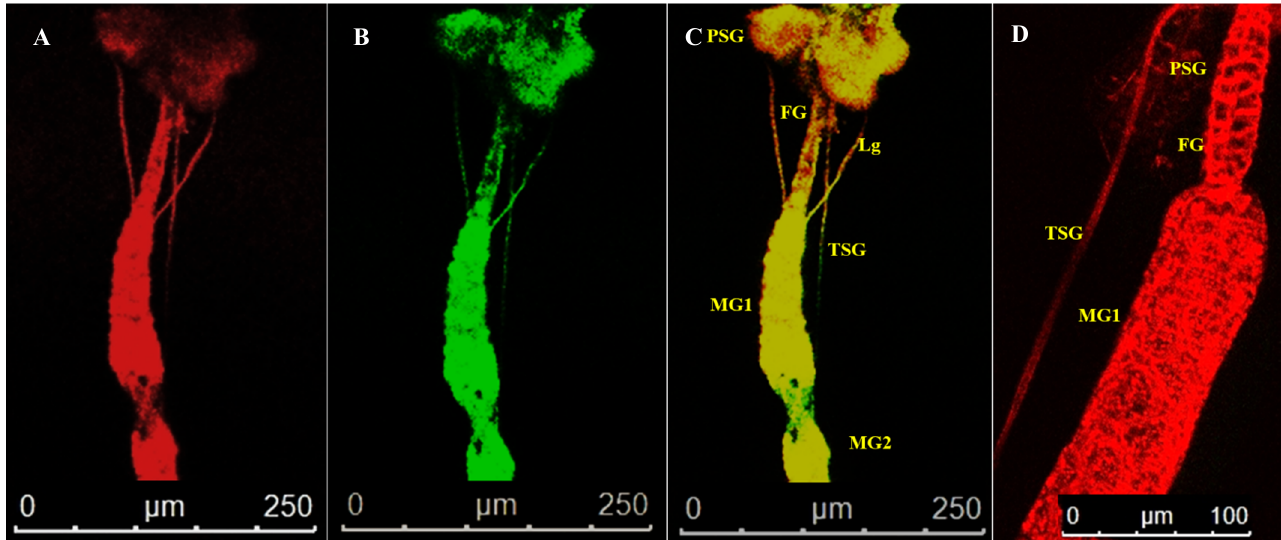
Figure 5. Accumulation of WBNV in ligaments and TSG of Thrips palmi during L2. ( A ). Alexa Fluor 594 phalloidin-conjugated F-actin probe emitting red fluorescence ( B ). FITC-conjugated goat anti-rabbit secondary antibody yielded green fluorescence indicating the presence of WBNV-N protein ( C ). Merging both Alexa Fluor 594 and FITC fluorescence signals yielded yellow-orange shades. ( D ). Merged Alexa Fluor 594 and FITC-specific fluorescence signals in non-exposed T. palmi indicating absence of WBNV. FG—foregut; MG1—midgut 1; MG2—midgut 2; PSG—principal salivary gland; TSG—tubular salivary gland; Lg—ligament. WBNV infection progressed from anterior midgut to PSG via ligaments 60 h post acquisition. Infection of TSG was also visible in some specimens during L2 stage.